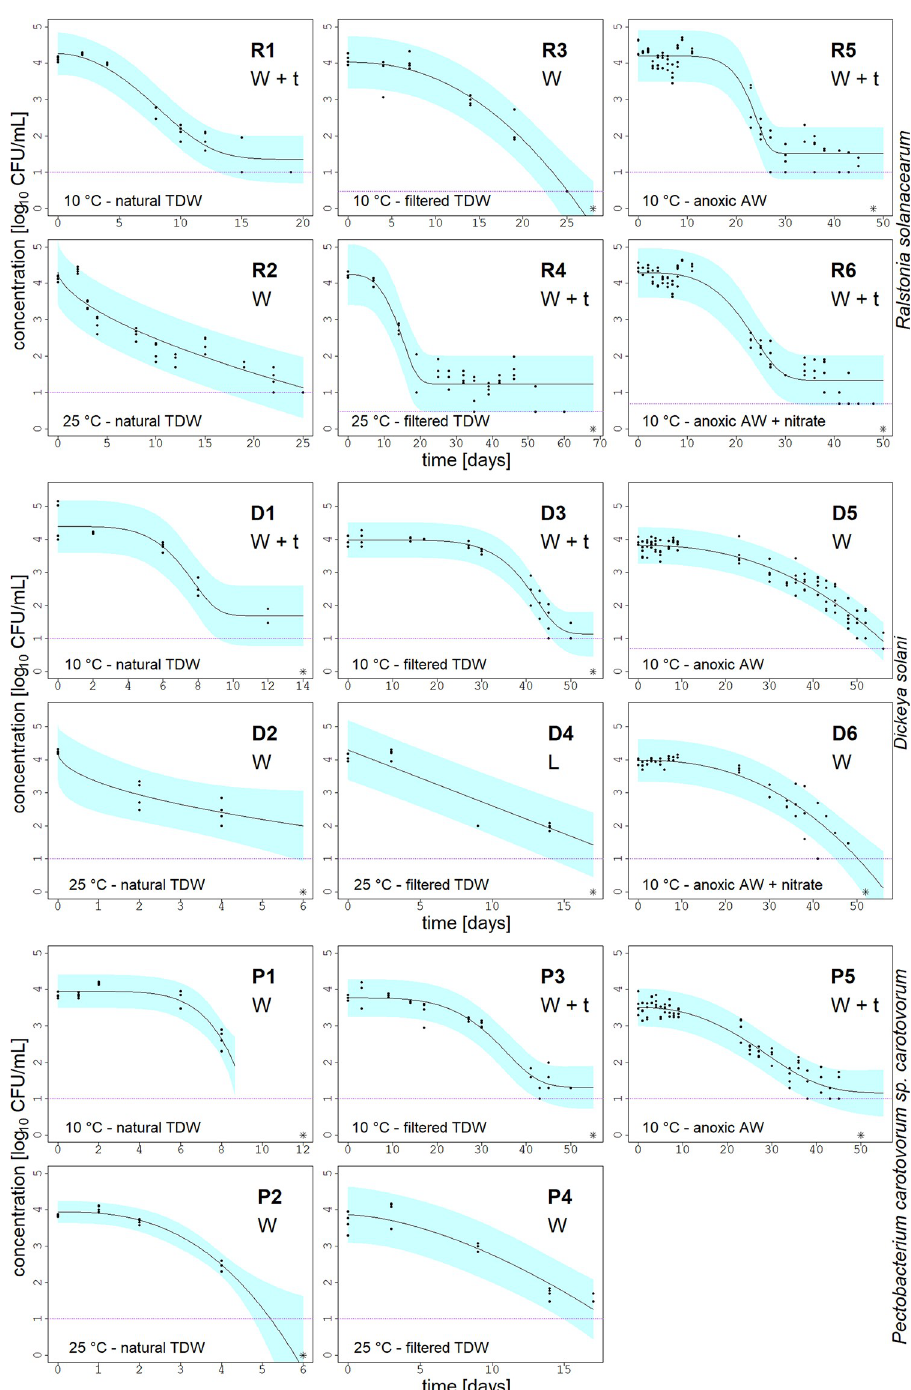
Fig 3. Die-off curves of plant pathogens. Die-off of Ralstonia solanacearum , Dickeya solani , and Pectobacterium carotovorum sp. carotovorum in microcosms under varying conditions, shown as log 10 [CFU/mL] vs. time [days]. The experimental conditions are displayed in the lower left corner of each graph. Points represent the plate counts in duplicate of two microcosms per treatment. The solid black line displays the model fitted to the data. The blue area depicts the 95% prediction interval of the model and the purple dotted line is the detection limit. The model applied used to fit the data is shown in the right corner of each graph: W+t stands for Weibull + tail, W for Weibull and L for log-linear model. The asterisk sign accounts for the last measurement point, where no more viable colonies were detectable.